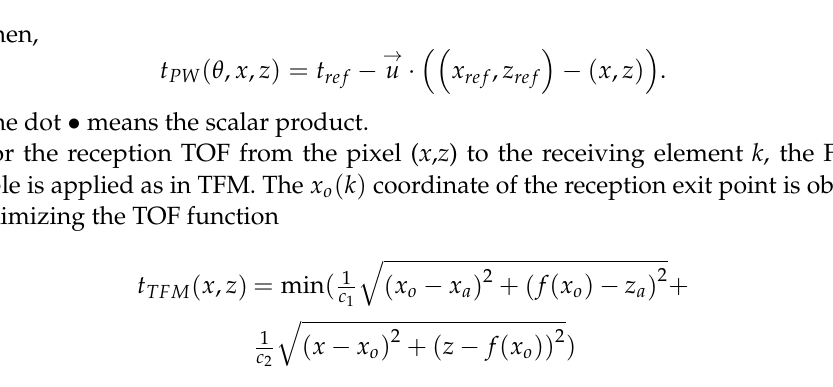
Figure 8. Sketch showing the geometry of refraction and the variables used for time-of-flight calcu- lation.